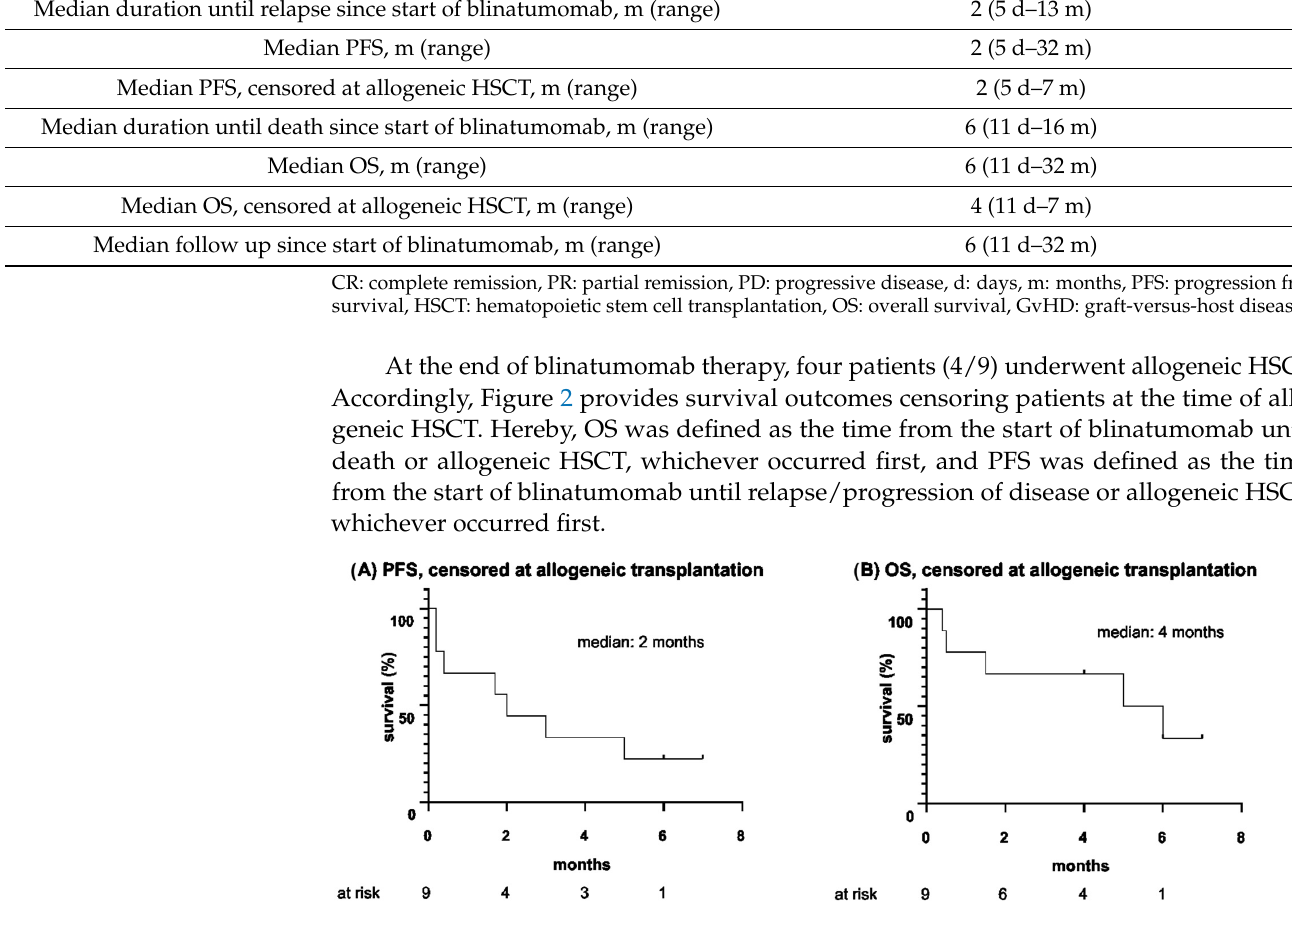
Figure 2. ( A ) Progression-free survival and ( B ) overall survival since the start of blinatumomab therapy, censored at allogeneic hematopoietic stem cell transplantation (months).